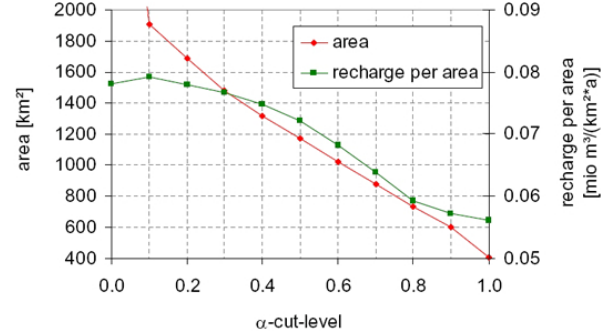
Fig. 7. α -cuts for the Maawil plume.